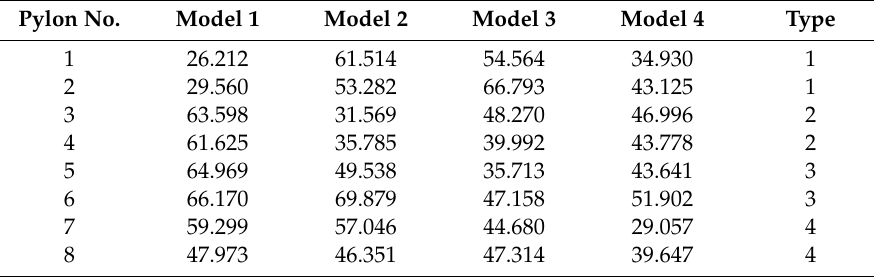
Table 3. Different shape matching Table 3. Di ff erent shape matching costs.